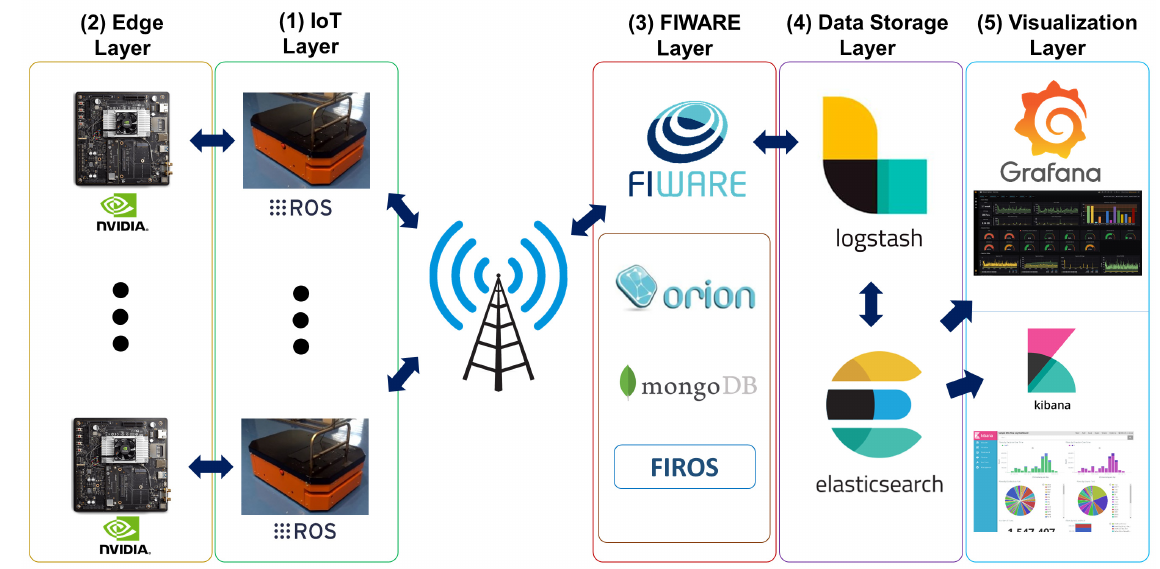
Figure 2. The ATV use case for proposed generic architecture.